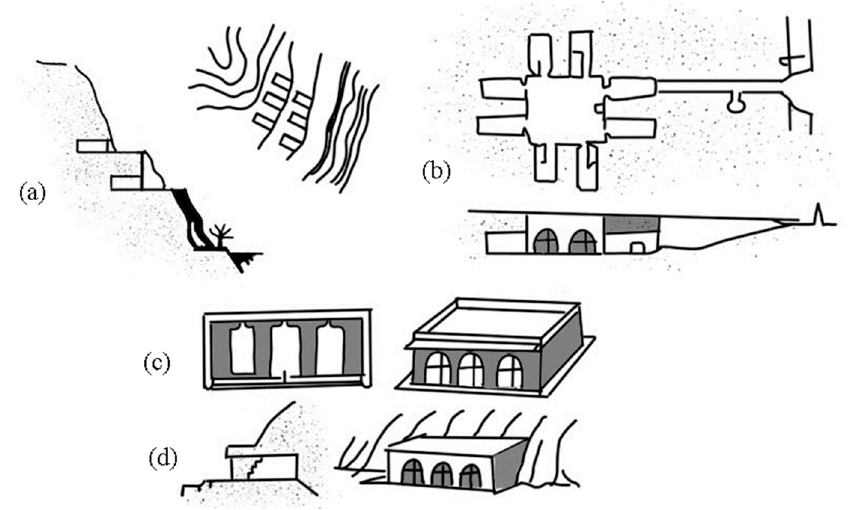
Figure 1. Three categories of cave dwellings: ( a ) and ( b ) excavation pattern; ( c ) masonry pattern; and ( d ) half excavation and half masonry pa tt ern.